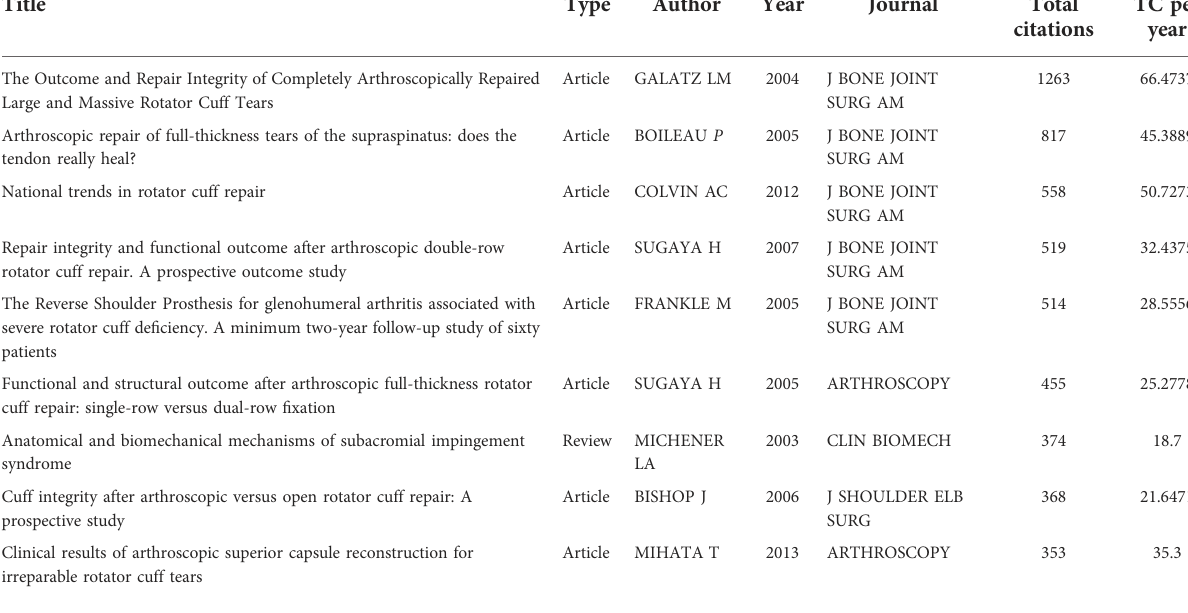
TABLE 1 General information about the top 10 most-cited